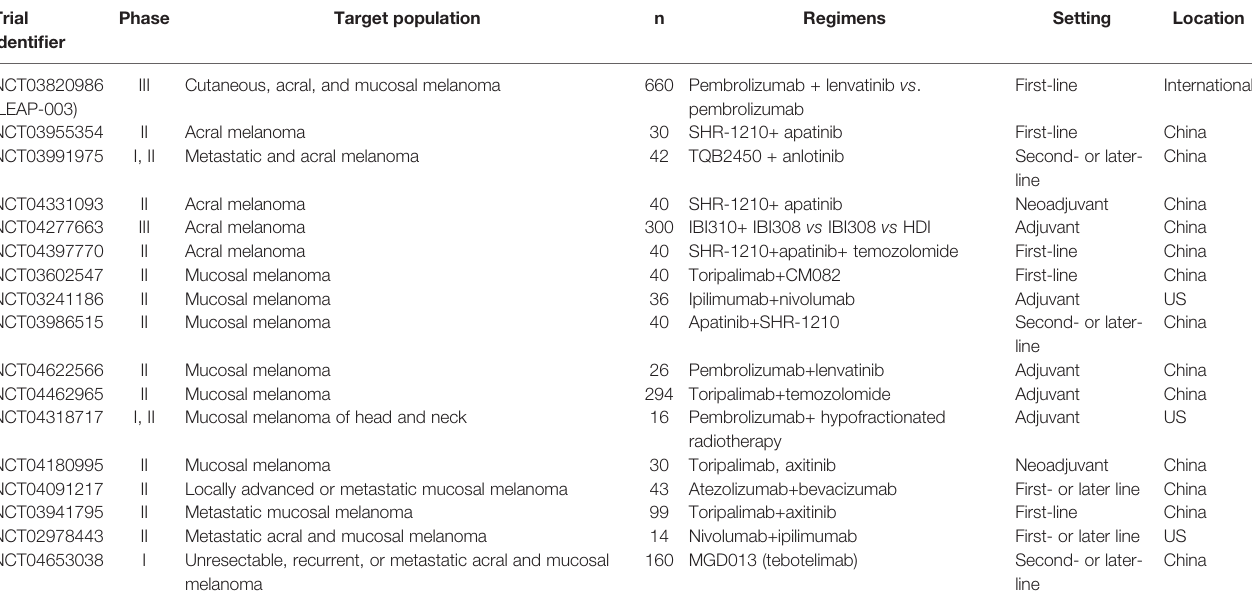
TABLE 3 | Summary of ongoing immunotherapy trials for the treatment of acral and mucosal melanoma. Trial identi fi